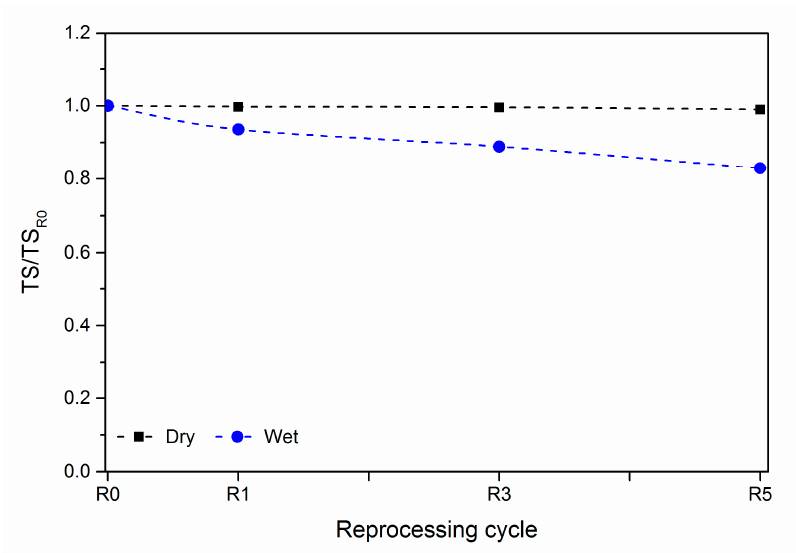
Figure 6. Dimensionless tensile strength as a function of the reprocessing cycles.